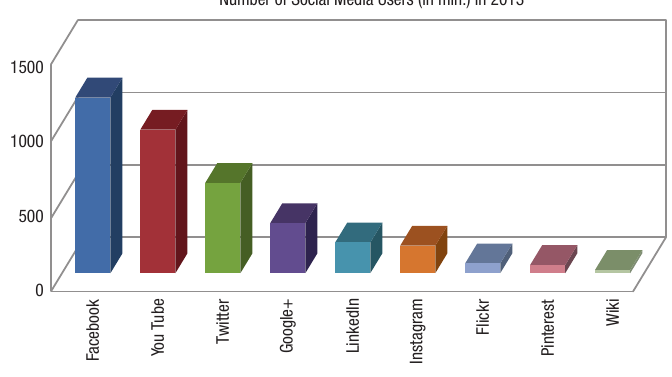
Fig. 2. Usage of social media in 2013